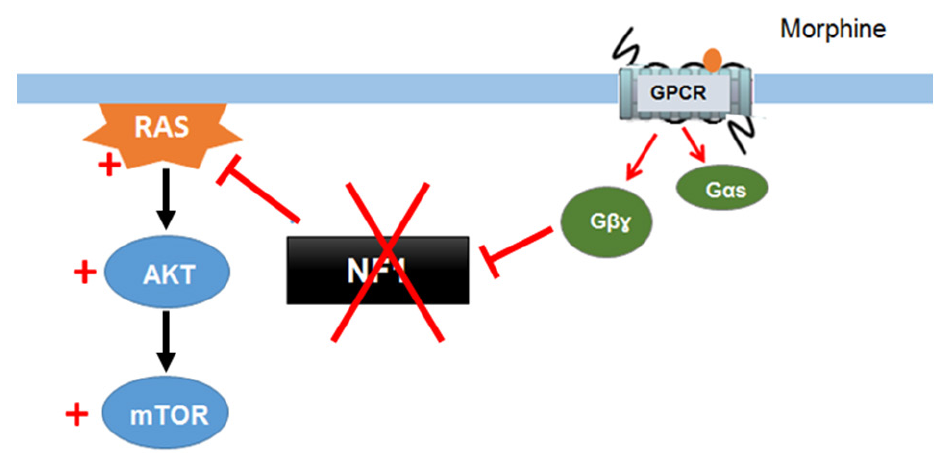
Figure 12. Neurofibromin mediates cross talk between GPCR (opioid receptors) and Ras / AKT signaling [132] .